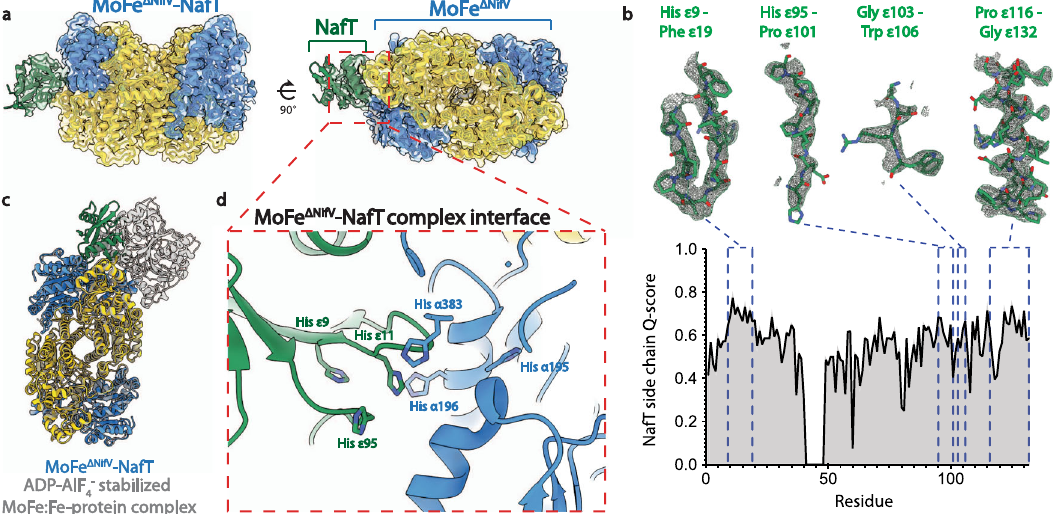
Fig. 5 | Structure of a previously uncharacterized MoFe Δ NifV -NafT complex revealed by cryoEM. a Classi fi cation of a subset of particles from the MoFe Δ NifV sample yields a 2.71Å resolution cryoEM map of MoFe Δ NifV in complex with the previouslyuncharacterizedproteinNafT(chain ε ;MoFe Δ NifV -NafT).Theatomicmodel oftheMoFe Δ NifV -NafTcomplexisshown fi tintothemap.Domainsarecolor-codedas follows: MoFe Δ NifV α - subunit, blue; MoFe Δ NifV β - subunit, yellow; NafT, green. b Upper